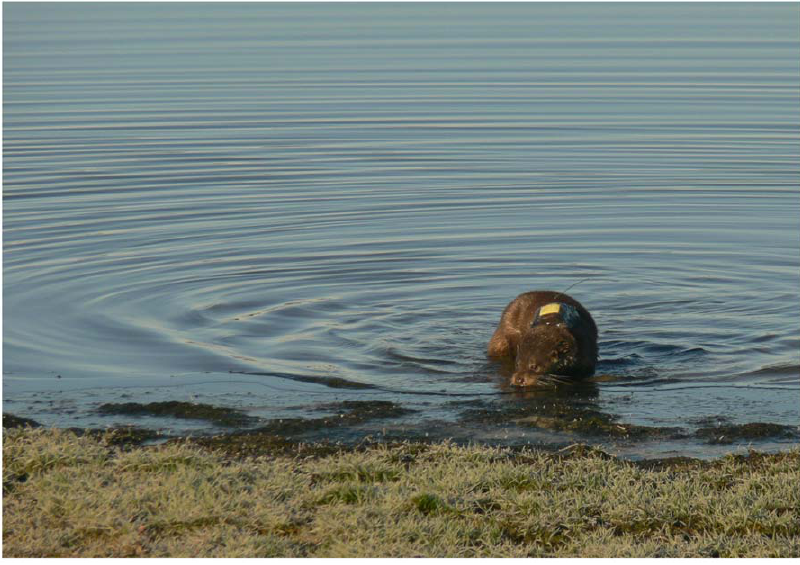
Figure 2. Wild free-ranging female otter ( Lutralutra ) fitted with a GPS harness after the release.